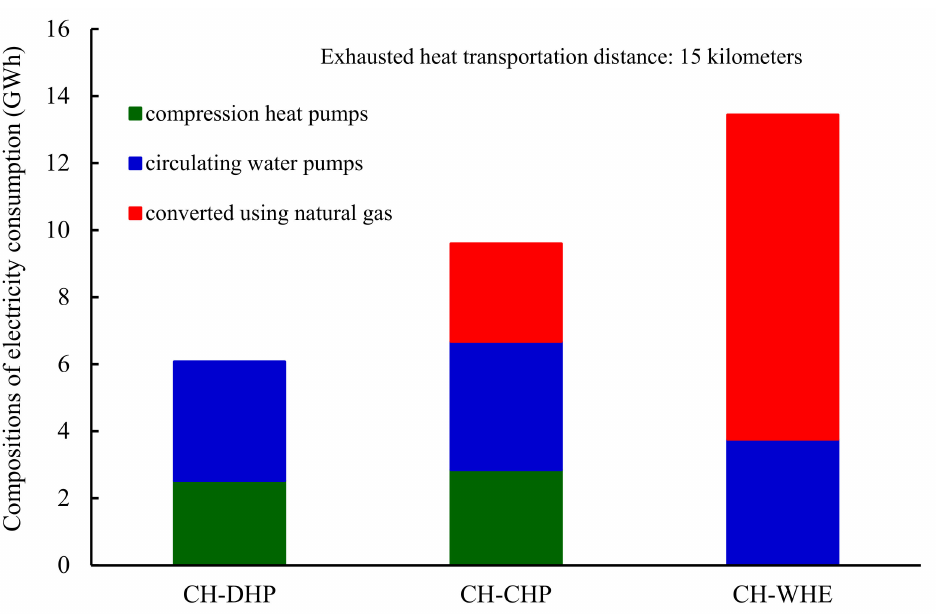
Figure 6. Distributions of annual electricity consumption of central heating scheme.